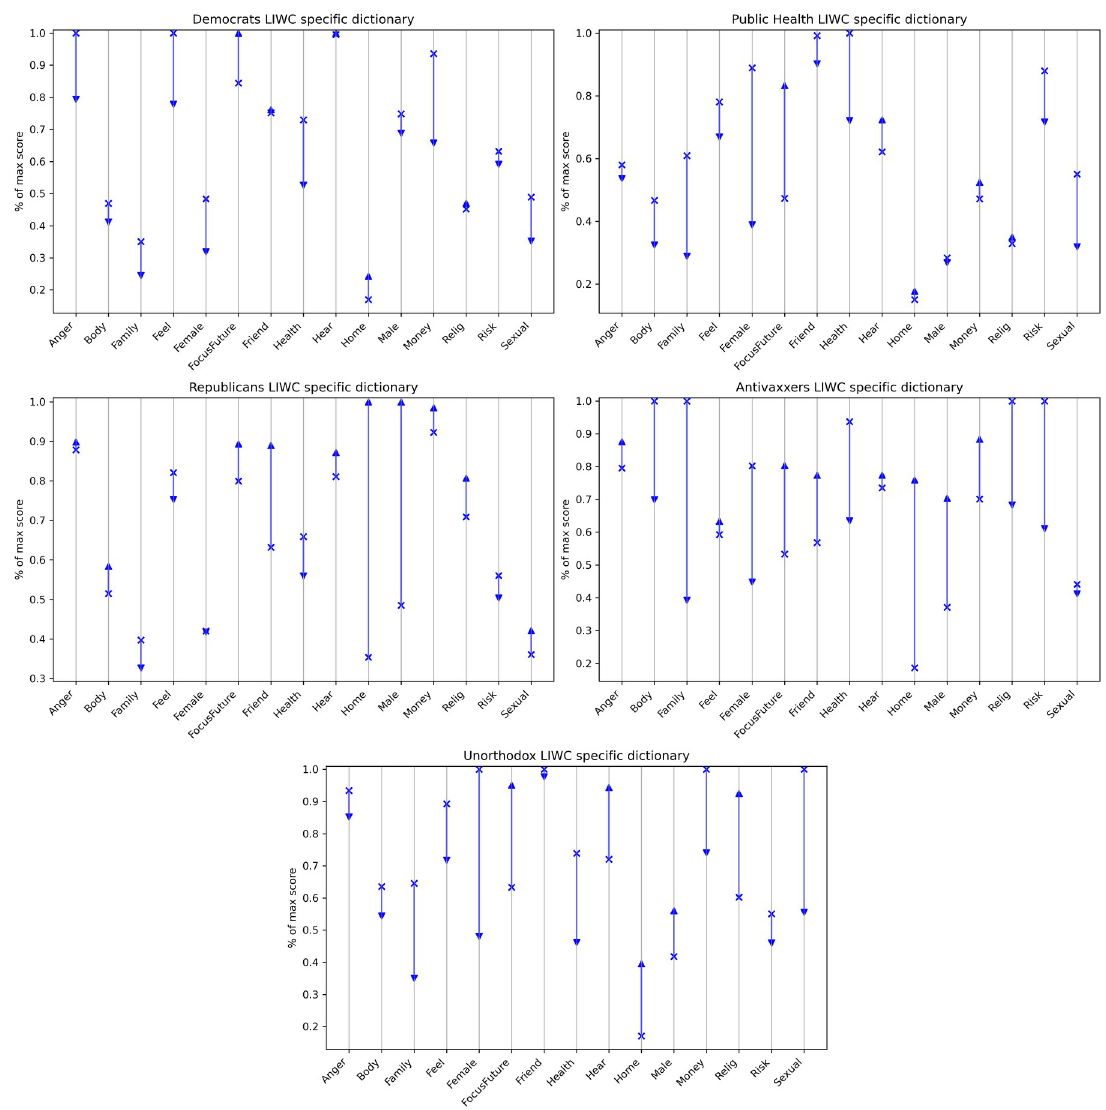
Fig 5. Changes on selected LIWC components pre- and post-declaration. X axis shows top 15 absolute score changes. Y axis shows percentage of max pre/post score. Arrow shows direction of